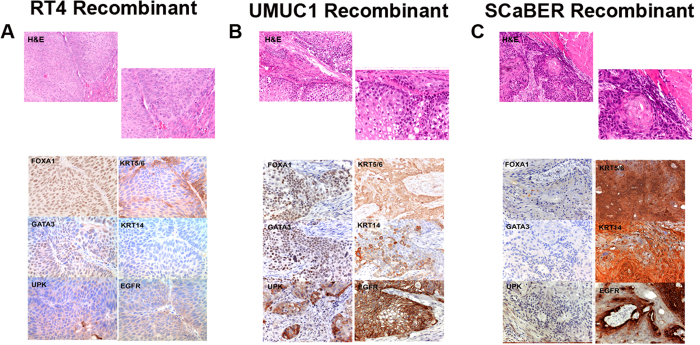
In vivo experiments show a subset of human cancer cell lines exhibits histomorphology and marker expression consistent with molecular subtype assignment.Hematoxylin and eosin stain (top panels) and immunohistochemistry for the luminal markers FOXA1, GATA3, and UPK, as well as the basal markers KRT5/6, KRT14, and EGFR following tissue recombination of (A) RT4, (B) UMUC1, and (C) SCaBER human bladder cancer cell lines.